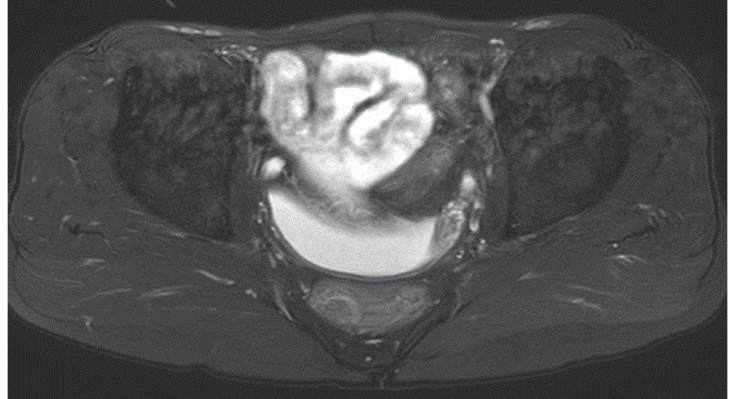
figure 4 - MRI showing the ureters anteriorly and the prostatic utricle cyst posteriorly. The bladder is